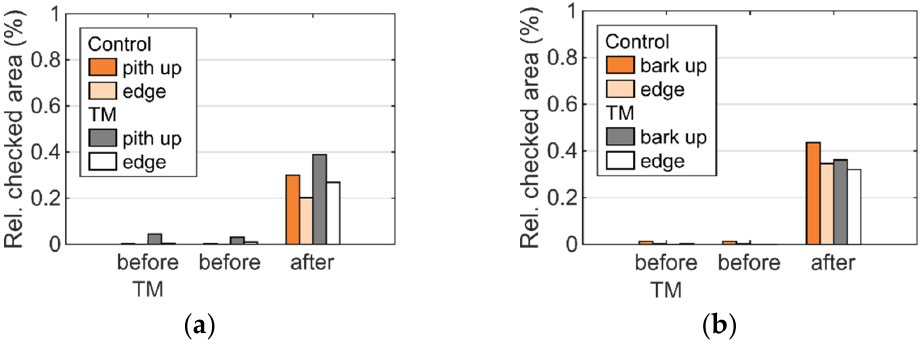
Figure 6. Mean relative area of surface checks (% of total investigated area) from digital image processing of ‘exposed’ control and TM boards before and after exposure per group: ( a ) pith side (group 1 and 3) and ( b ) bark side (group 2 and 3).